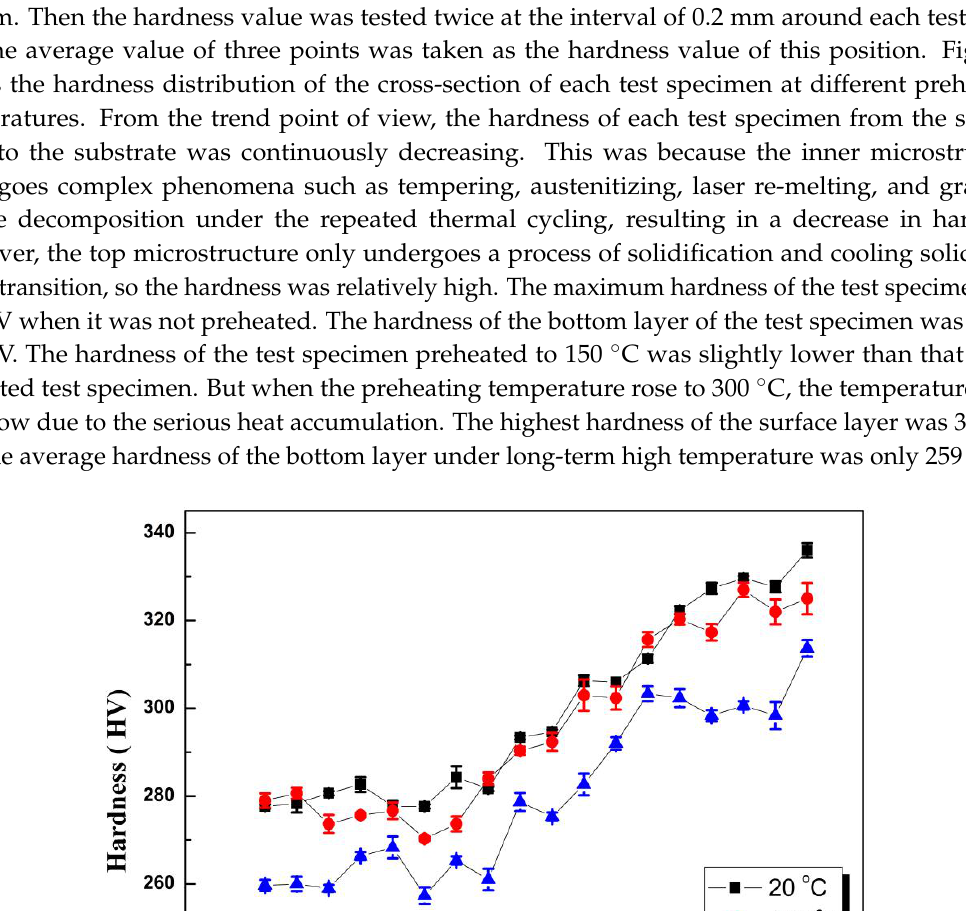
Figure 4. Hardness of different preheating temperature.